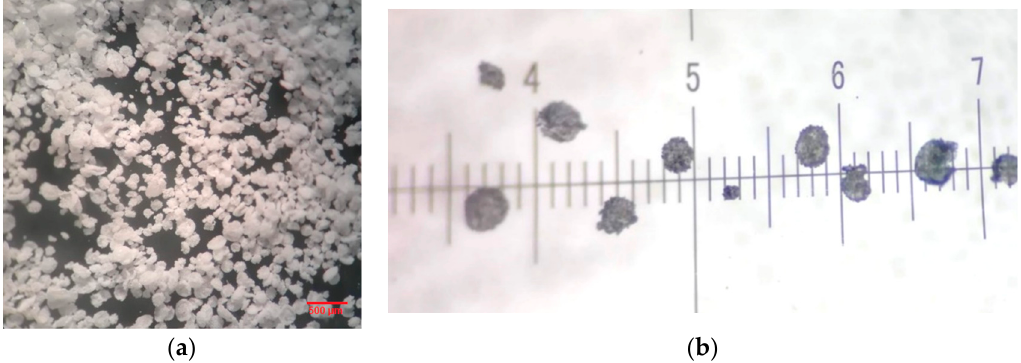
Figure 4. Sample taken during microcapsule synthesis process (optical image, 25× zoom).